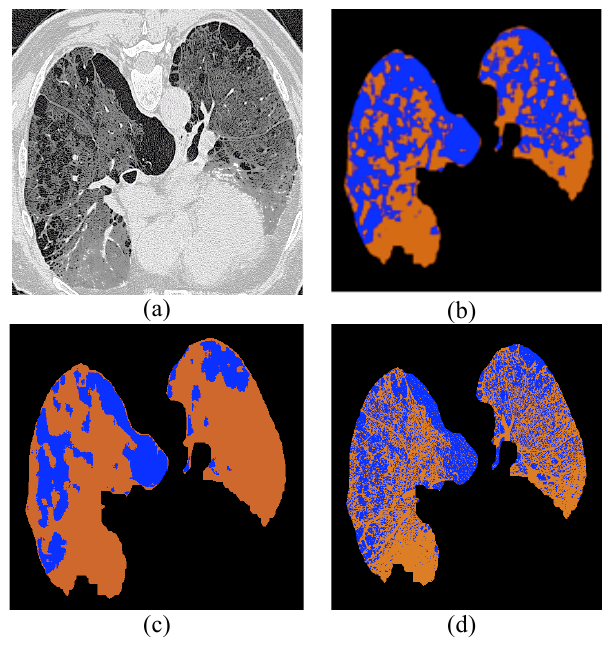
Figure 2 : 2(a) contains the original image where the dark regions correspond to emphysema. 2(b) and 2(c) and 2(d) are the outputs of C4.5 in original feature space and in the feature space chosen by CFS respectively. The blue regions correspond to